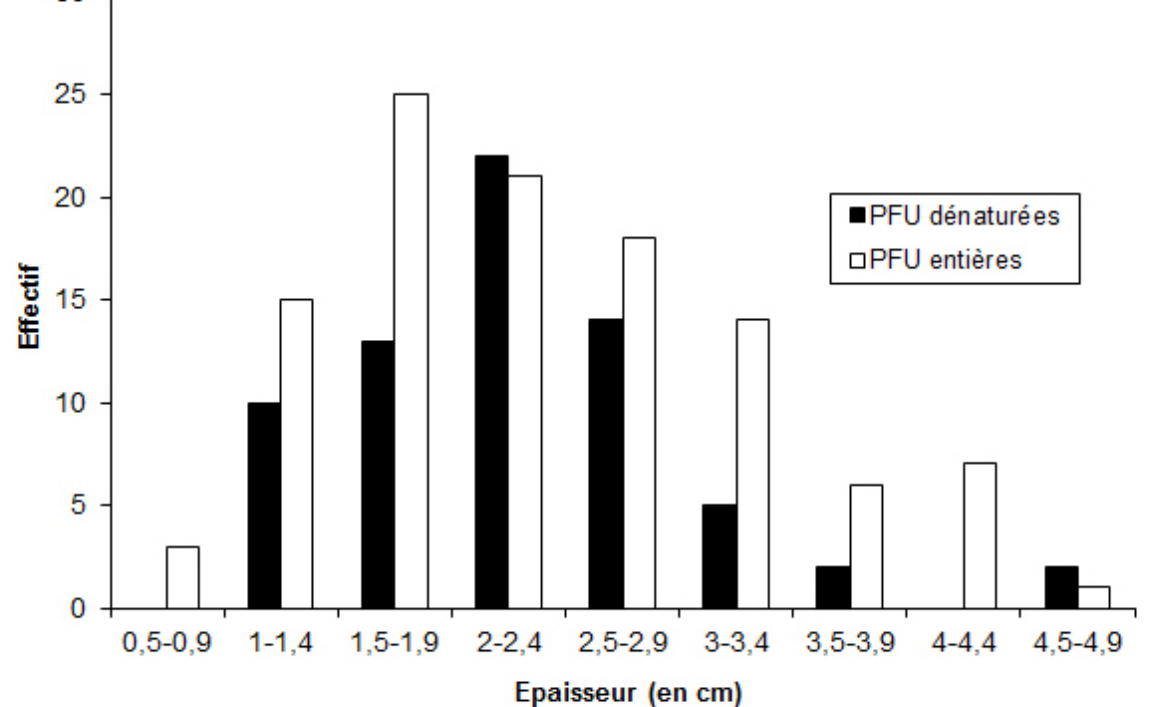
Figure 12. Histogramme des épaisseurs des pièces façonnées unifacialement de GO-JA-01. Figure 12. Histogram of thickness of unifacially shaped artefacts from GO-JA-01